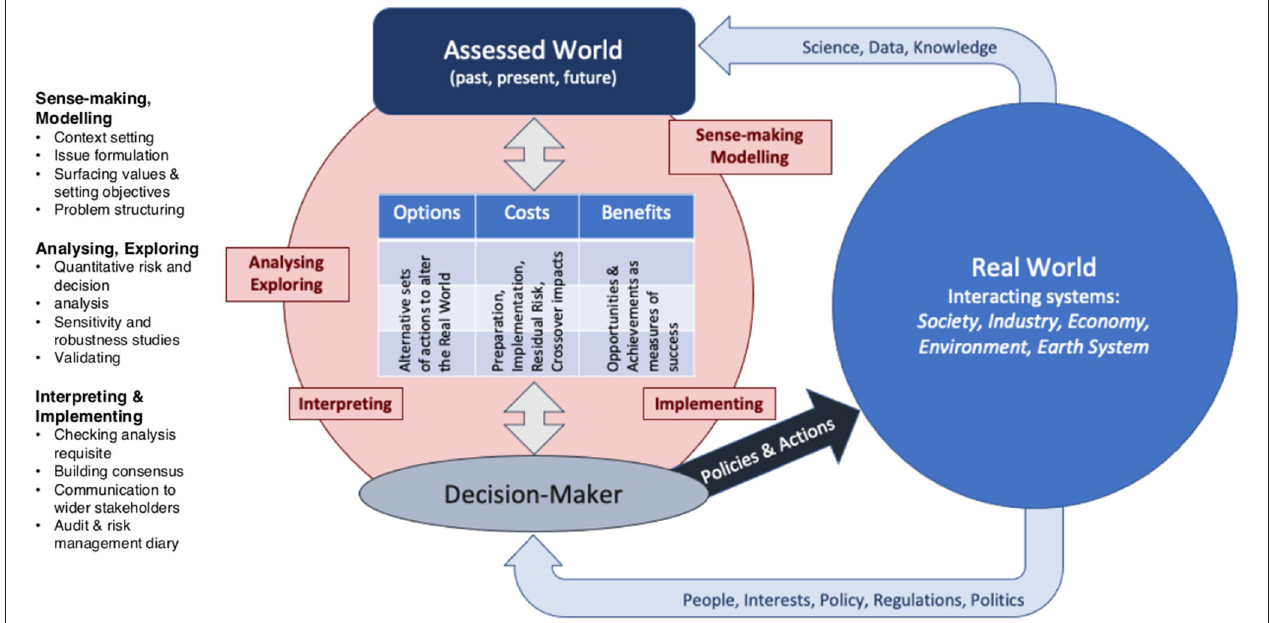
FIGURE 5 | Setting the three decision making phases into a wider context of a control system. The left-hand side of the graphic corresponds with the human processes of conceptualizing, modeling, analyzing and deliberating on the issues; the right-hand side to the real world and society. In a well-developed simple control system, the “Science, Data, and Knowledge” are measurements (feedbacks, monitoring) of the real world, the “sense making” will have been previously simplified to one or more target objectives, the “analysis and exploration” process is simplified to estimating the difference between the state of the system and the target/desired state, and the “interpretation and implementation” process is simplified to pre-agreed actions to move the system from its current state to the target